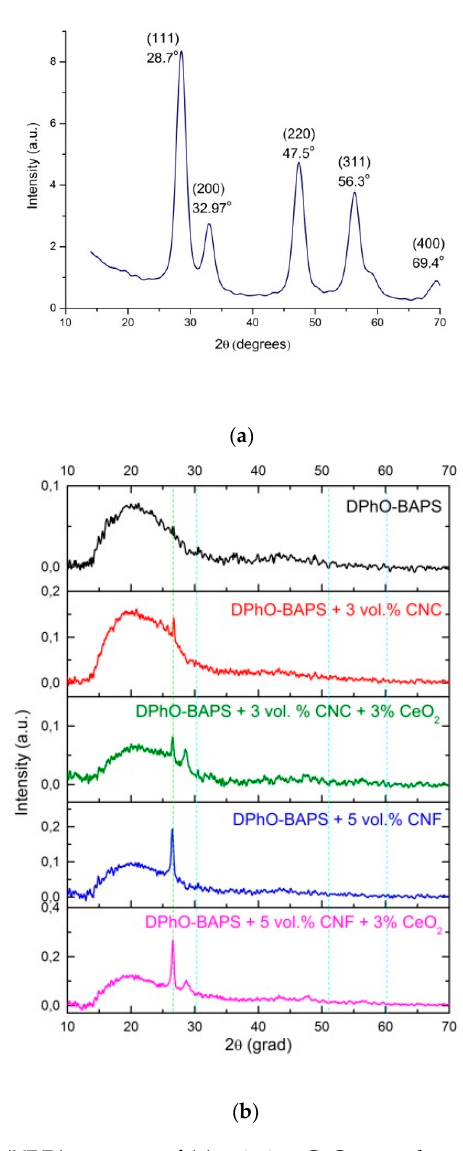
Figure 4. X-ray diffraction (XRD)patterns of ( a ) pristine CeO 2 powder and ( b ) DPhO-BAPS matrix, as Figure 4. X-ray di ff raction (XRD) patterns of ( a ) pristine CeO 2 powder and ( b ) DPhO-BAPS matrix, well as its nanocomposites with various combinations of nanoparticles. as well as its nanocomposites with various combinations of